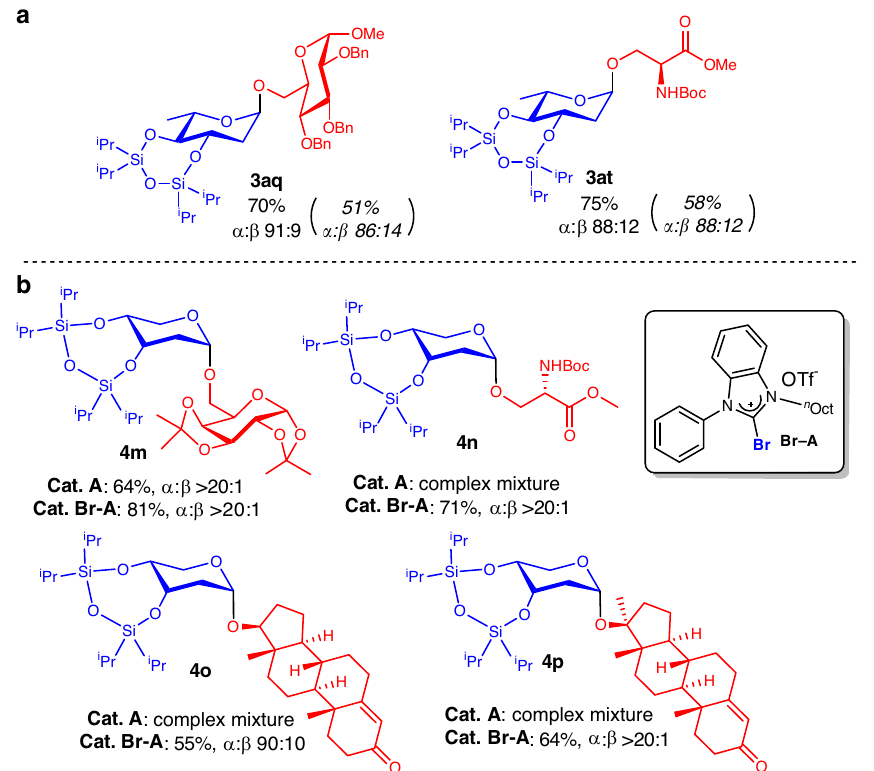
Fig. 11 XB tunability. a Elevation of yields on rhamnosides using the sequential procedure, yields, and selectivity from standard conditions indicated in parenthesis. b Iodine to bromide halogen swapping on A resulted in signi fi cantly expanded 2-deoxyribosylation